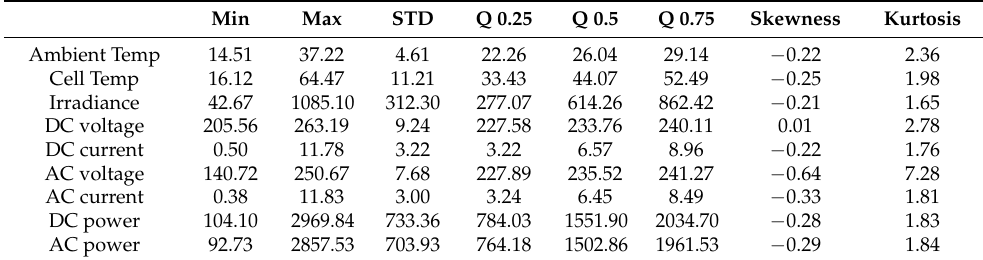
Figure 4. Distribution of the investigated time-series data. Table 4. Descriptive statistics of the training